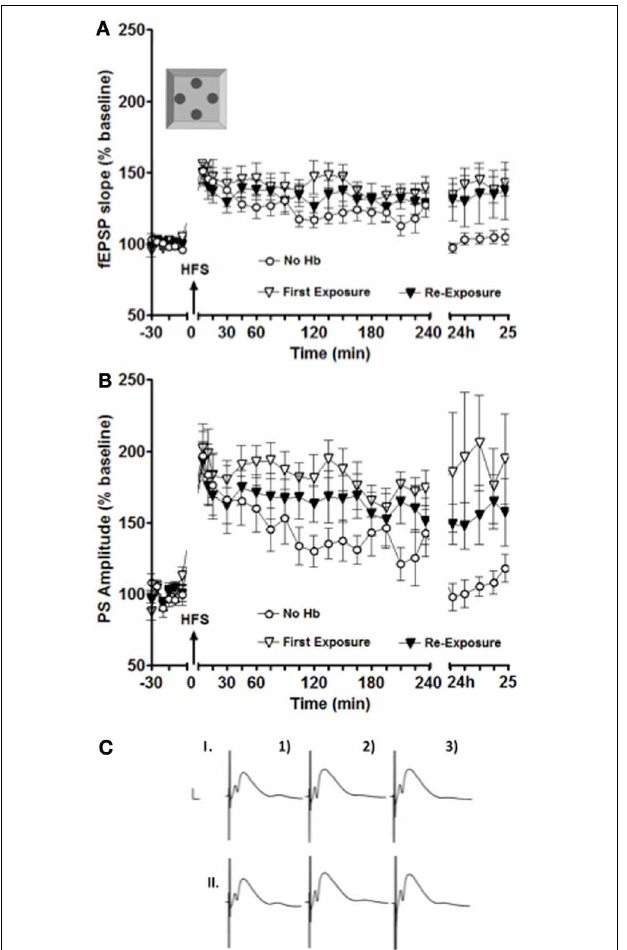
FIGURE 2 | LTP facilitation was still observed in the intermediate DG after the second exposure to the holeboard. (A,B) show a facilitation of LTP for both fEPSP (A) and PS amplitude (B) at 24h after the first (white inverted triangles) and the second (black inverted triangles) exposure to the holeboard ( n = 9). The white circle data set represents results from an experiment, where HFS was applied alone without a concurrent holeboard exposure. (C) Shows examples of analog recordings of intermediate DG potentials during the first (I) and the second (II) holeboard exposure experiment 5min before (1), 5min after (2), and 24h after (3) HFS. Vertical bar: 5mV, horizontal bar: